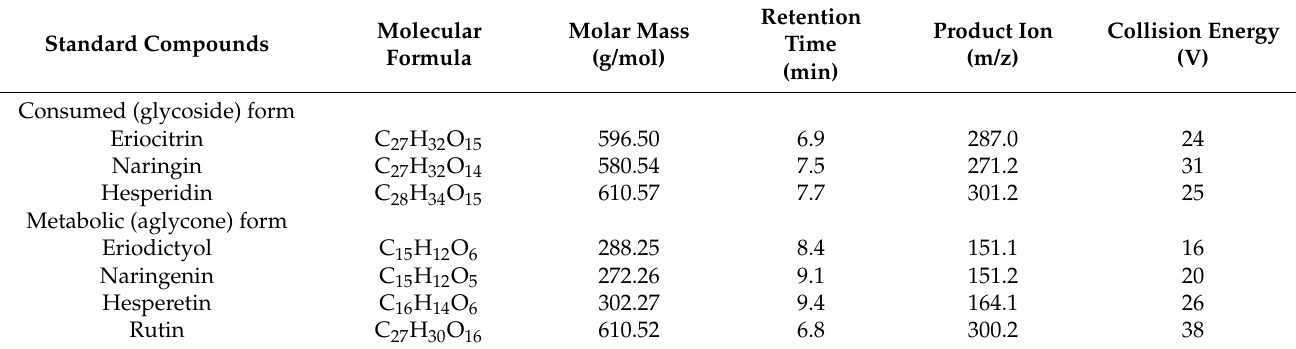
Retention Molecular Molar Mass Formula (g/mol)